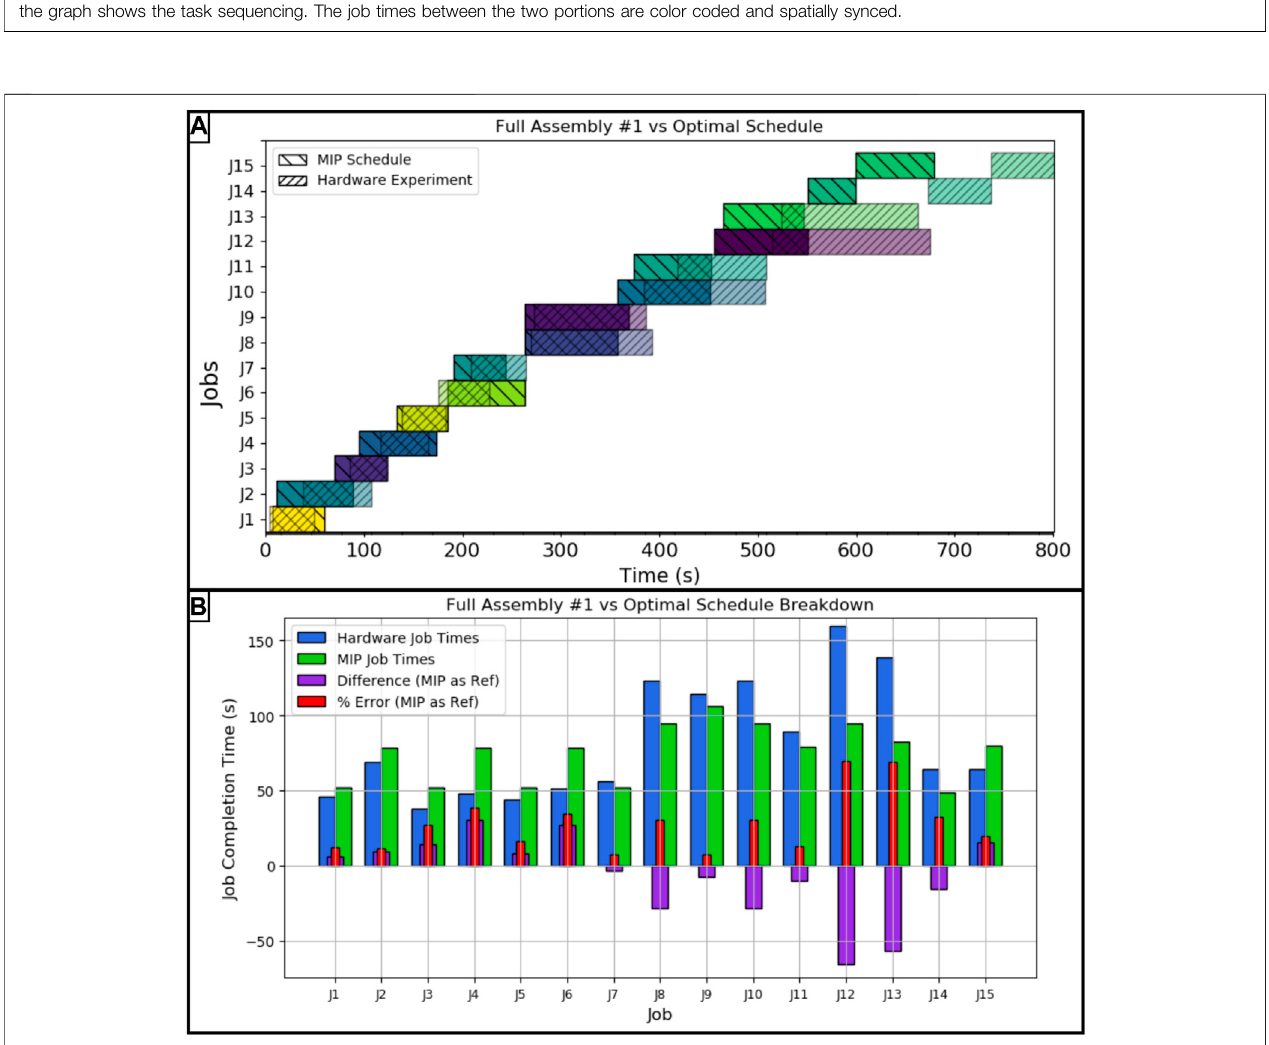
FIGURE5|(A) Hardwarevs.MIPoptimalscheduleforthe fi rstfullassemblyrun, (B) :Jobbyjobbreakdownwitherrorforthe fi rstfullassemblyrun.Thejobkeyisas follows: J 1: Mlb 2, J 2: Mlb 1, J 3: Mmb 2, J 4: Msbm 1, J 5: Mmb 1, J 6: Msbc 2, J 7: Msbc 1, J 8: Cmb 1 lb 1, J 9: Csbm 1 sbc 1, J 10: Cmb 2 lb 2, J 11: Mmb 1 lb 1, J 12: Csbc 2 sbm 1, J 13: Mmb 2 lb 2, J 14: Msbc 1 sbm 1 sbc 2, J 15: Csbc 1 sbm 1 sbc 2.